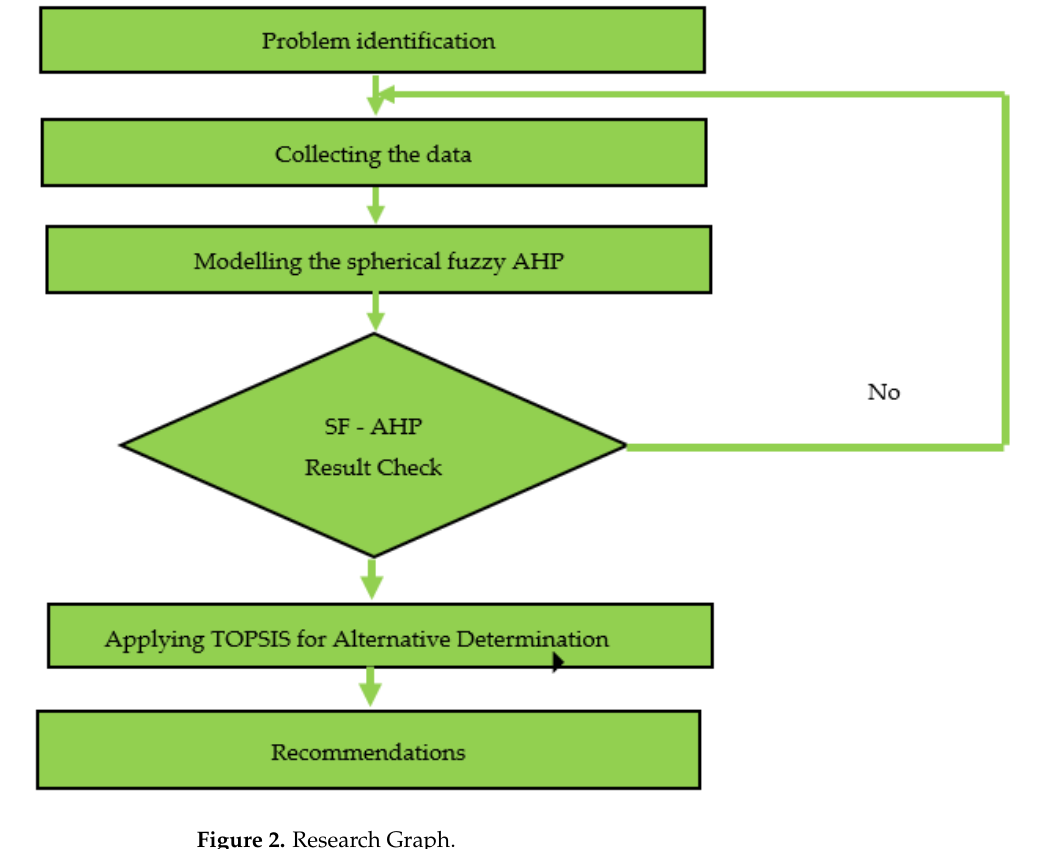
Figure 2. Research Graph .